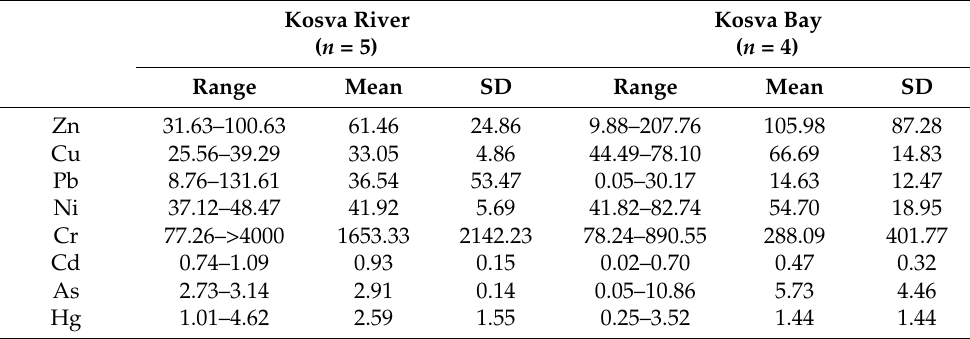
Table 4. Comparison of the chemical composition of sediment samples from this study with the upper continental crust (UCC) [85].